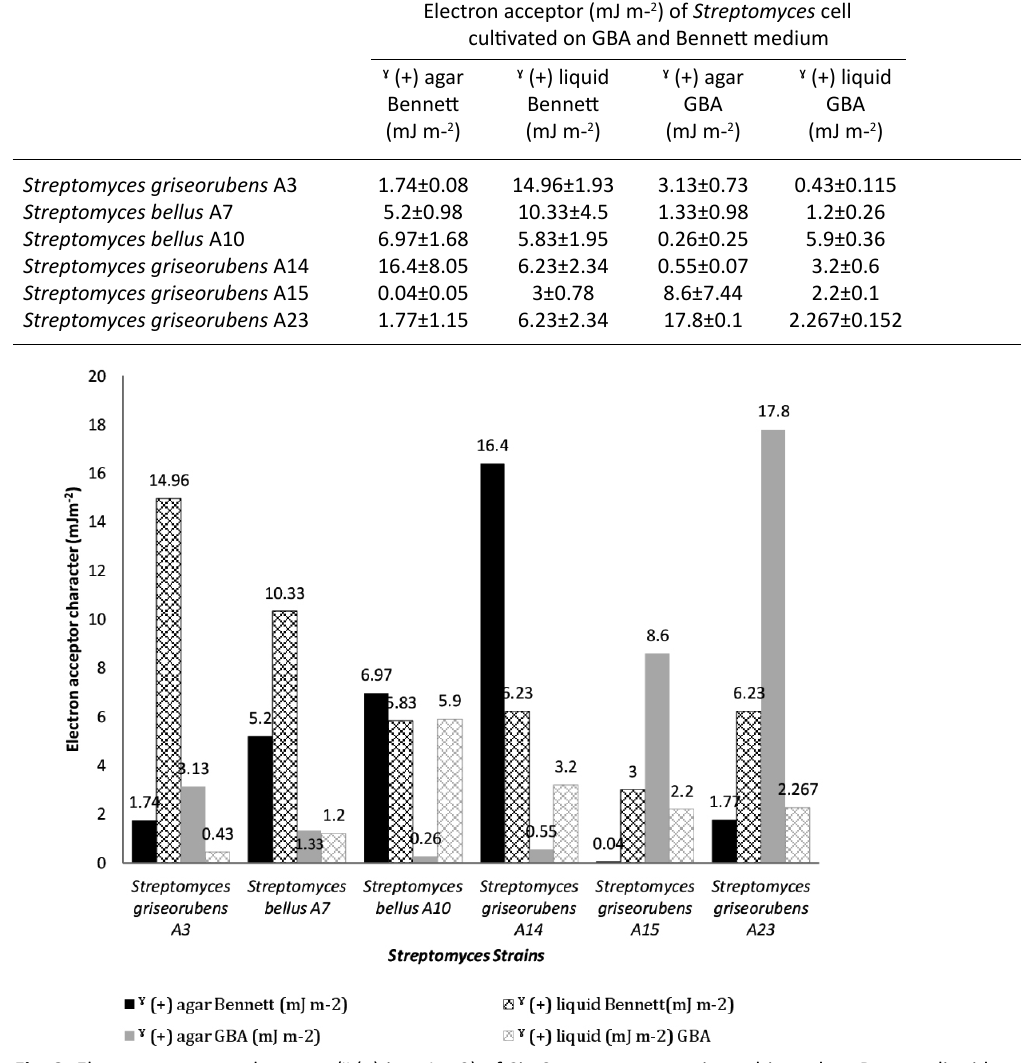
Fig. 3. Electron acceptor character (ˠ (+) in mJm-2) of Six Streptomyces strains cultivated on Bennett liquid, agar Bennett, GBA liquid and agar GBA